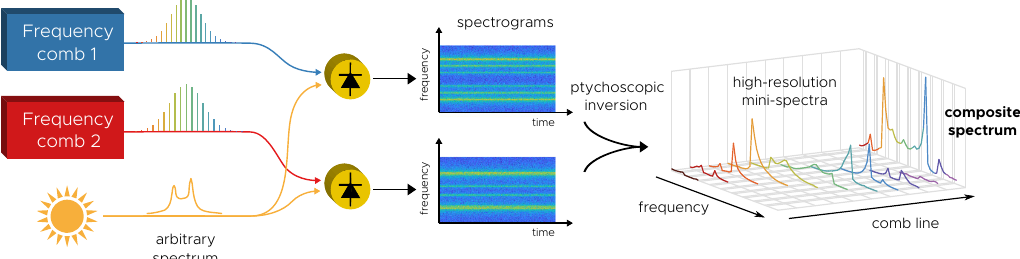
Fig. 1 Essential idea of frequency comb ptychoscopy. An arbitrary spectrum is independently beat with two combs, resulting in a pair of spectrograms. By using a ptychoscopic inversion procedure, high-resolution mini-spectra are produced, representing the beating of the source with each comb line. These spectra are limited in bandwidth by photodetection, but their resolution is Fourier-limited. By compositing these spectra, a high-resolution broadband spectrum is